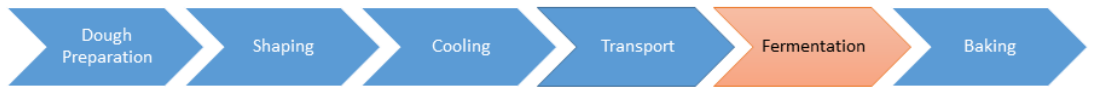
Figure 1. Bread manufacturing process.